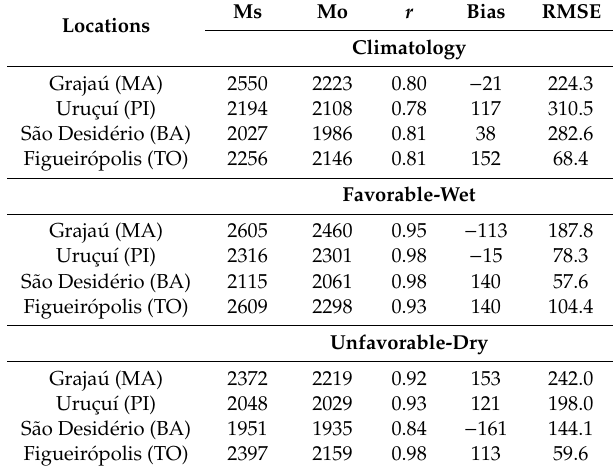
Figure 8. Simulated Water Requirements Satisfaction Index (WRSI) of soybean crops for different sowing dates and locations in MATOPIBA, considering three meteorological conditions. Table 6. Performance of the CROPGRO-Soybean crop model for soybean yield simulation in 33 crop seasons, considering three meteorological